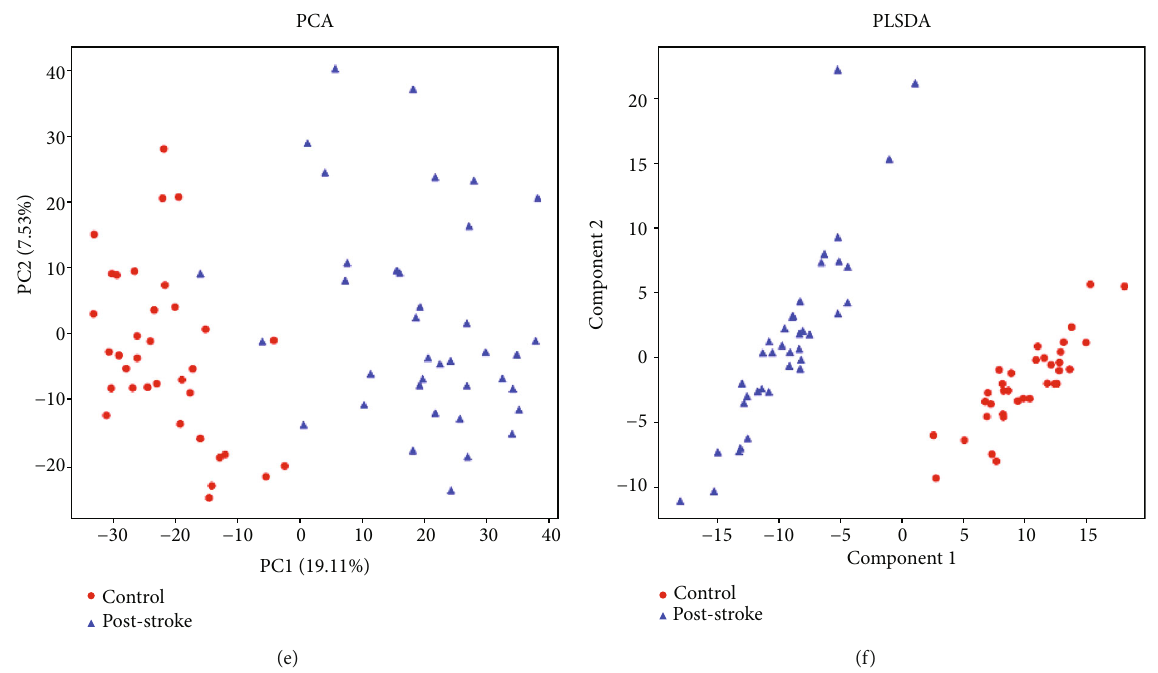
Figure 1: Diversity of gut microbiota. (a) Venn diagram of common OTUs. (b, c) Alpha diversity is estimated with the ace and Shannon index. (d – f) Beta diversity was estimated with Bray-Curtis, PCA, and PLS-DA. OTU: operational taxonomic unit; PCA: principal coordinates analysis; PLS-DA: partial least squares discrimination analysis. ∗ p < 0 : 05